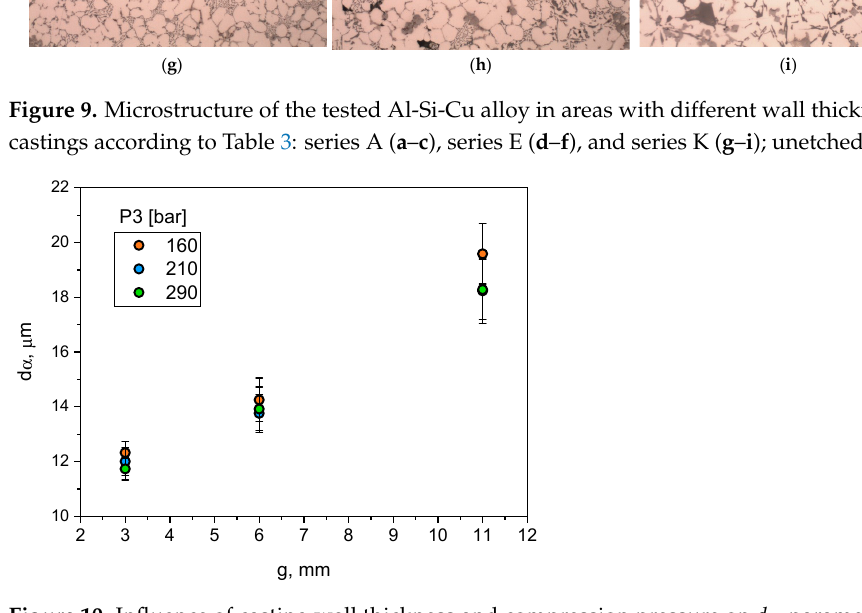
Figure 10. Influence of casting wall thickness and compression pressure on d α parameter.